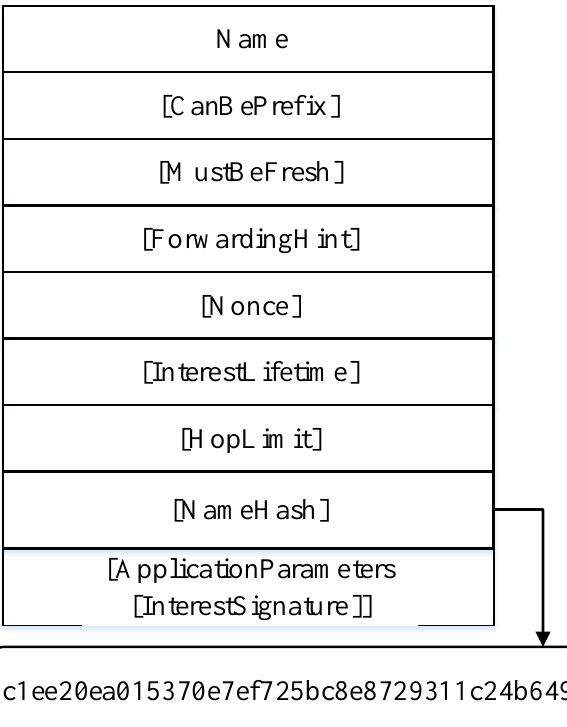
Figure 4. NameHash-based interest